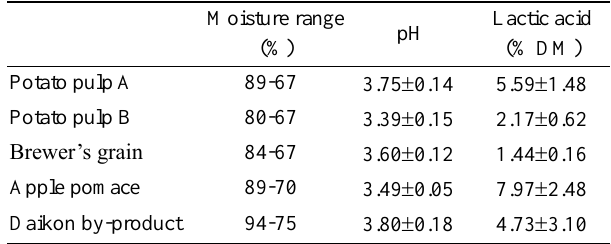
Table 2. Mean fermentation characteristics of the HMBF silages used in the